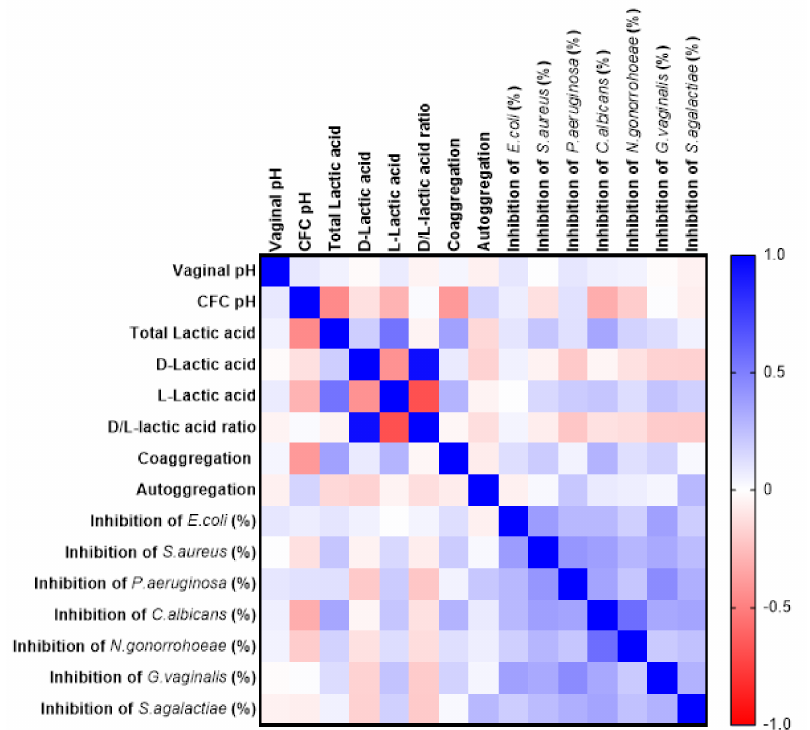
Figure 9. Relationship of di ff erent functional properties of lactobacilli with each other. The Spearman’s correlation matrix indicates the correlation nature between the lactobacilli probiotic traits. Dark blue color on the scale denotes a perfect positive correlation ( r = 1) and dark red indicates a perfect negative correlation ( r = −